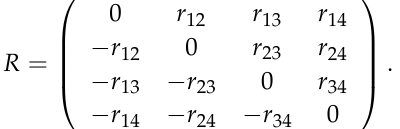
Figure 7. Schematic drawing of three agents in an arbitrary coordinate system. Their states are labeled (cid:126) s (cid:126) s (cid:126) s 2 and 3 . Relative references are labeled according to Equation (21) with 1 , vector from agent i to agent j . For readability, the inverse references (cid:126) r ij = − (cid:126) r ji are